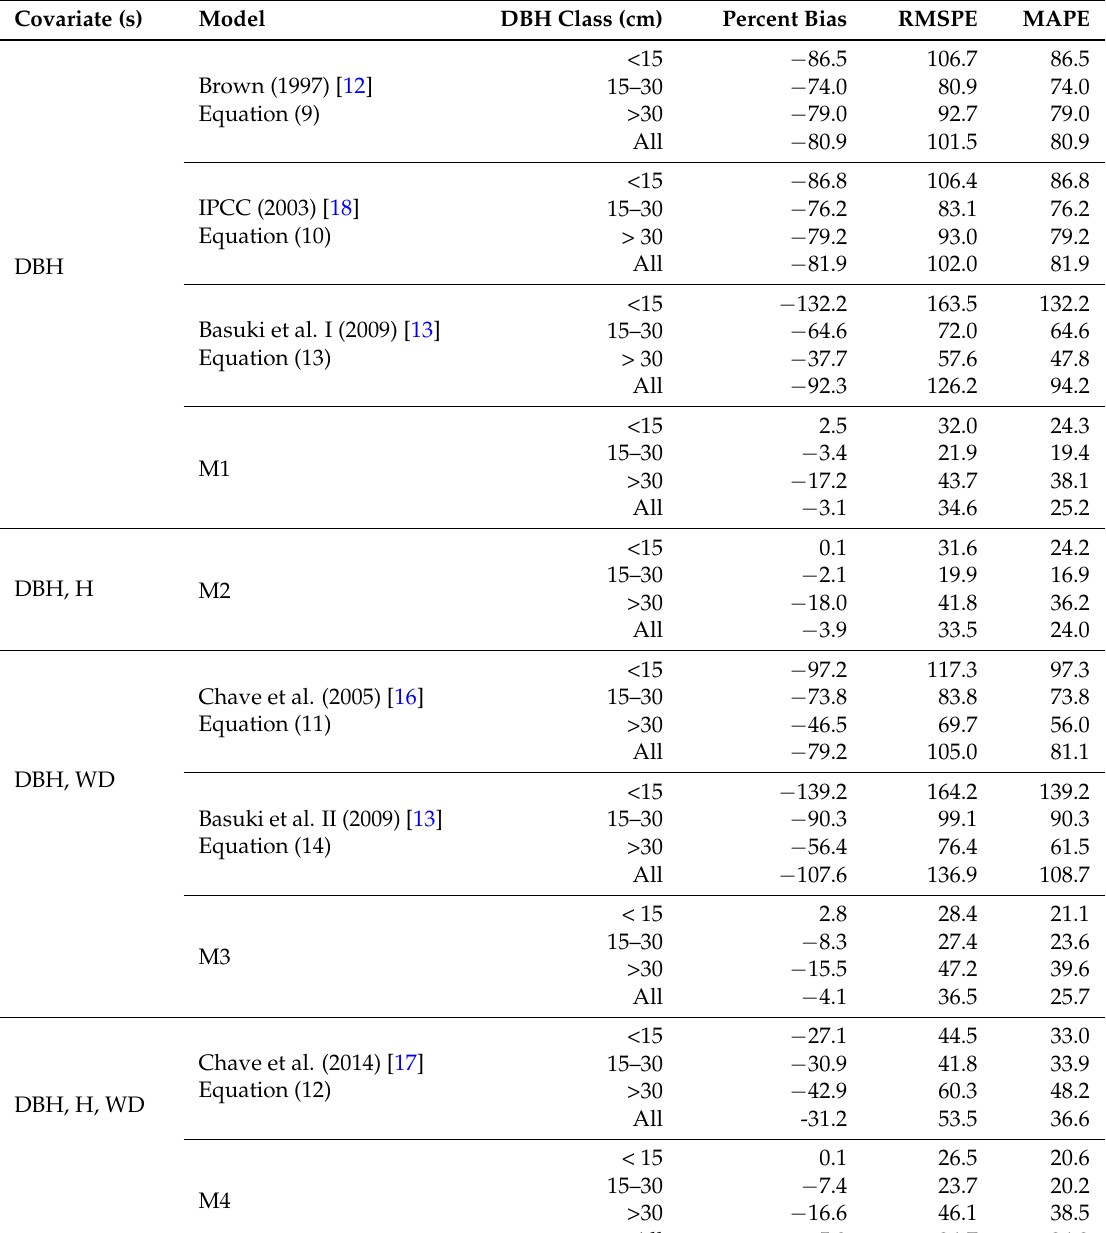
Table 7. Percent bias, RMSPE, and MAPE for the selected mixed-species models, mixed-species models for dipterocarp forest of Indonesia, and pantropical models for mixed-species by covariate (s). Covariate